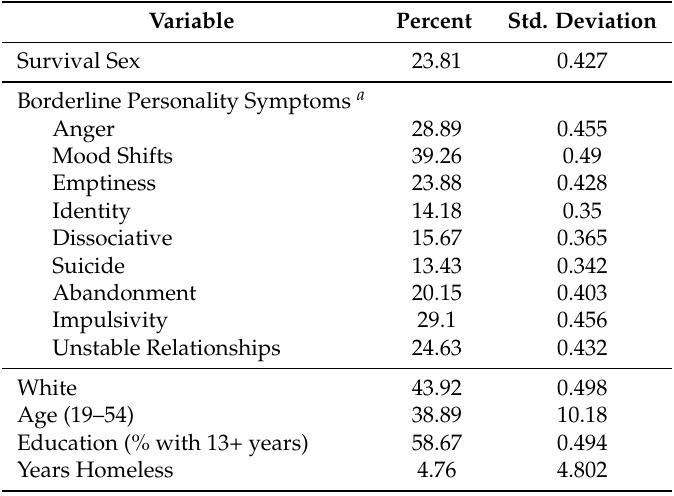
Table 1. Demographic and clinical characteristics (n = 158).